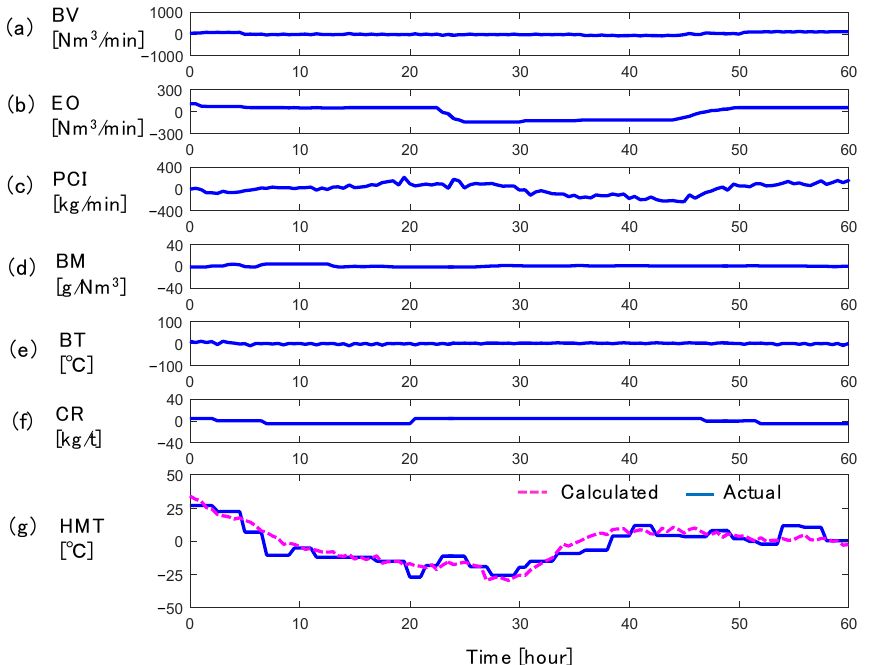
Figure 3. Simulation results of HMT by 2D transient model using real operation data: ( a ) blast volume, ( b ) enrichment oxygen flow rate, ( c ) PC flow rate, ( d ) blast moisture, ( e ) blast temperature, ( f ) coke rate, ( g ) hot metal temperature.